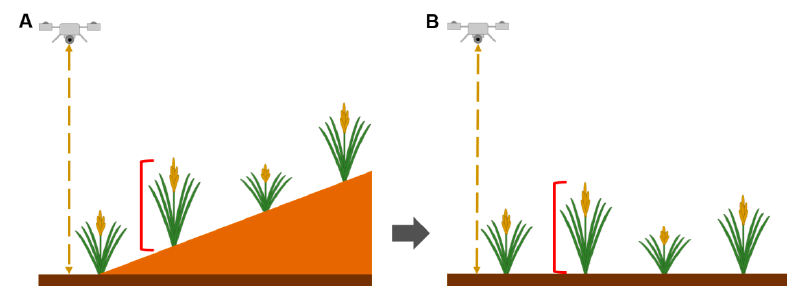
Figure 2. Marginalization of terrain variation to estimate plant height in an idealized setting of flat but sloped terrain. Inclusion of positional variables (e.g., latitude and longitude) as covariates allows terrain variation to be marginalized in a randomized complete block design, as gradients explained by other variables are included in analysis of covariance (ANCOVA).